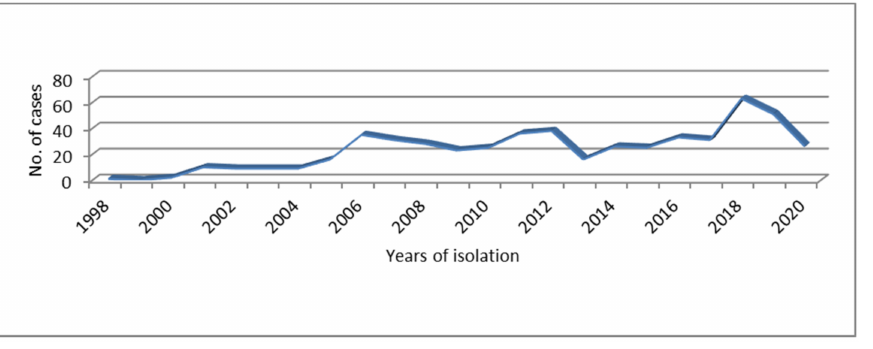
Figure 1. Distribution of Shiga toxin-producing Escherichia coli (STEC) O145 infections occurred in Argentina over